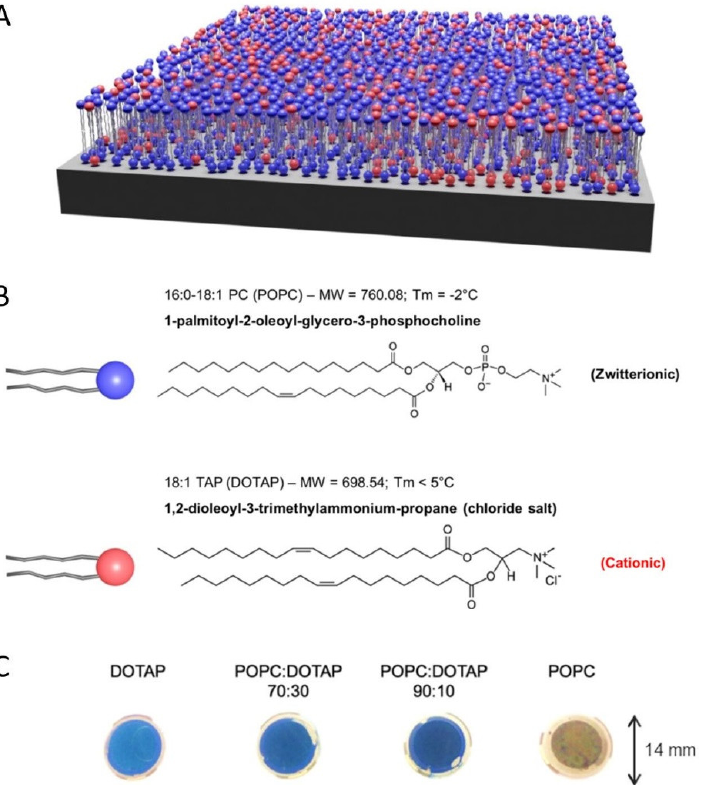
Figure 5. Schematic representation of the used SLB surfaces, example with 70% of POPC and 30% of DOTAP lipid bilayers ( A ) and chemical formula of the corresponding lipids POPC and DOTAP ( B ). Photographs of QCDM sensors after PB deposition on top of the SLB/SiO 2 surface ( C ).